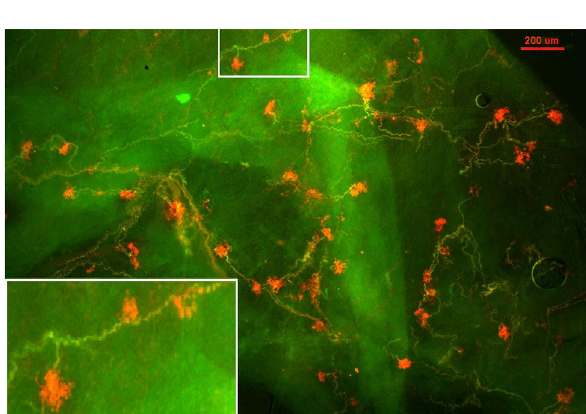
Figure 2. A double staining approach to illustrate BR structures. Na + /K + -ATPase stains all structures in the sensory unit (red); myelin basic protein (MBP) stains the myelin sheath (green) and co-staining shows yellow. Each red ball shaped end formation (a compact flower spray) is a receptor, demonstrated by a myelinated axon termination. The lower left corner is an enlargement of the structure in the up middle rectangular. The scale bar is 200